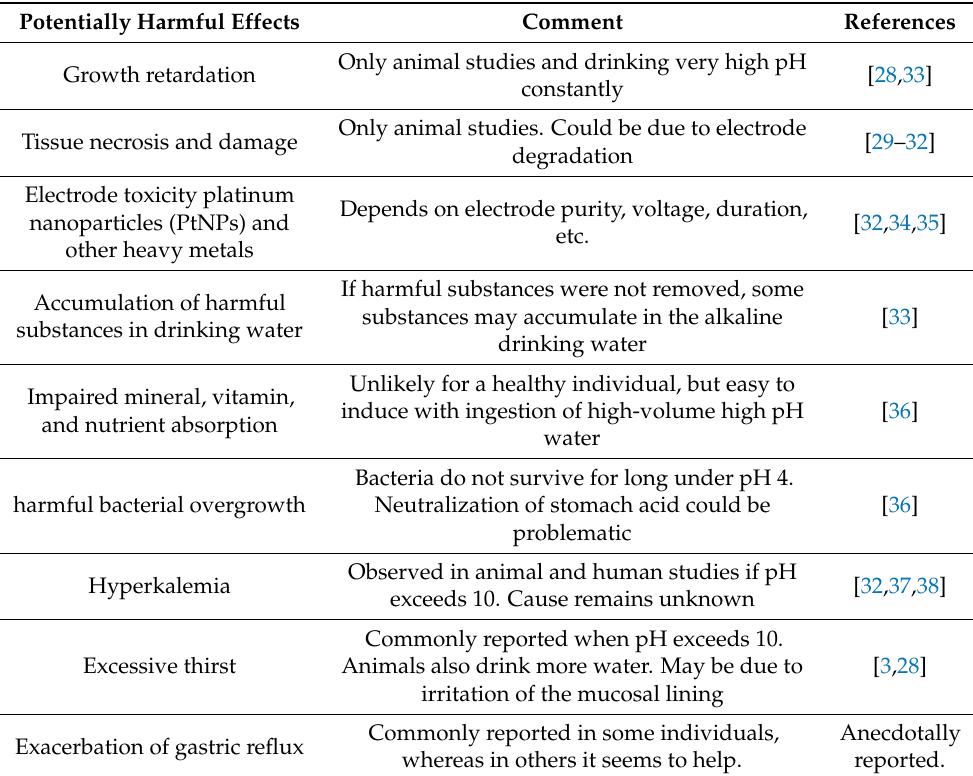
Table 1. Potential harmful effects from ingesting high pH alkaline ionized